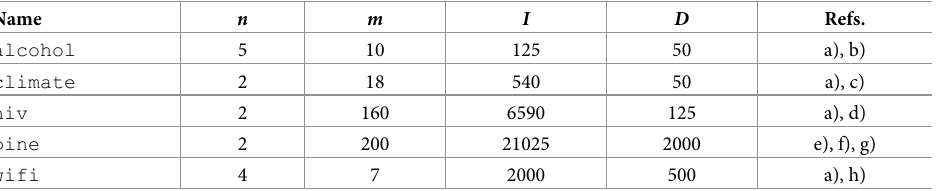
Table 2. Data set overview. Overview of the five real-world data sets and their basic characteristics: n is the number of classes, m is the number of features or, in other words, the dimension of the feature space X � R m , I is the total num- ber of datapoints, and D is the number of training datapoints. The number T of test datapoints is just T ≔ I − D . We abbreviate the references as a) [25], b) [26], c) [27], d) [28], e) [29], f) [30], g) [2], and h) [31]. Also, we turned the origi- nally multi-class data set pine into a binary problem as described in